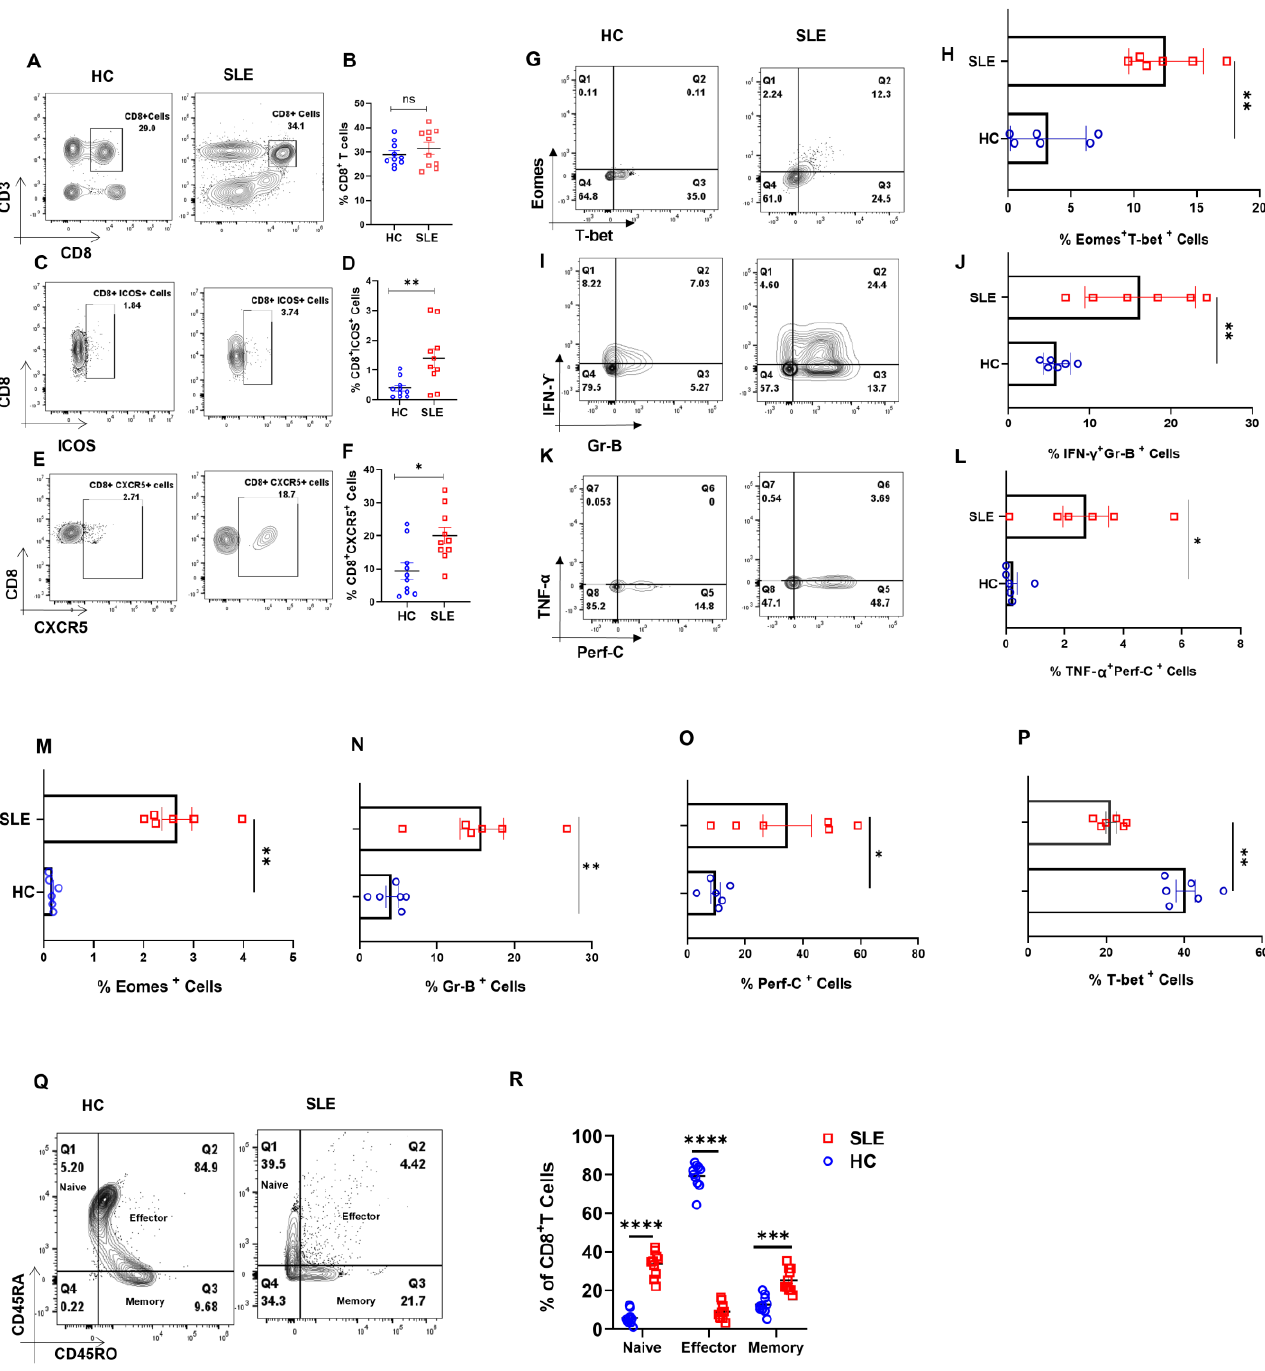
Figure 1. Dysregulated cellular differentiation and expression of activation marker in CD8 + T cells of SLE patients. SLE patients display higher activation marker including ICOS and CXCR5 in whole blood. Representative flow cytometry plots show % CD8 + T cells in whole blood of healthy controls ( n = 10) and SLE patients ( n = 10) ( A ) and cumulative graphical representation ( B ). Representative plots showing % ICOS expression in CD8 + T cells from whole blood of HC ( n = 10) and SLE patients ( n = 10) ( C ) and cumulative graphical representation ( D ). Representative plots showing expression of % CXCR5 expression on CD8 + T cells from whole blood of HC ( n = 10) and SLE patients ( n = 10) ( E ) and cumulative graphical representation ( F ). SLE patients ( n = 6) display higher expression of Eomes and T − bet dual-positive CD8 + T cells than healthy controls ( n = 6) while a reversed trend is observed for T − bet, representative flow cytometry plots ( G ) and cumulative graphical representa- tion ( H ). Representative flow cytometry plots showing increase in inflammatory cytokines IFN −γ,